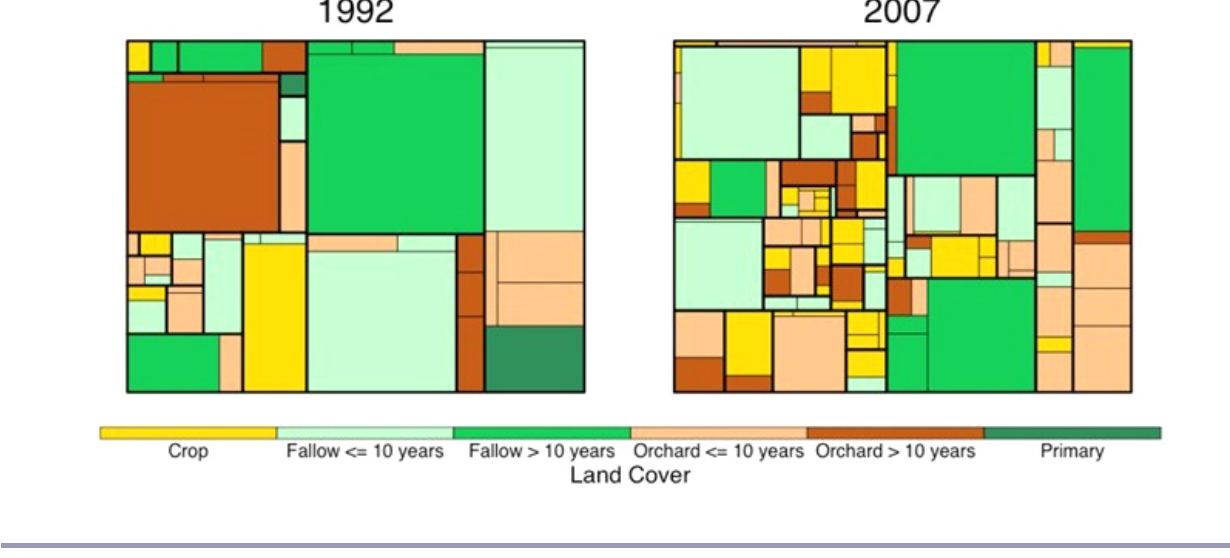
Fig. 5 . Tree maps of land cover by household holdings, San Jose, in 1992 and 2007. Bold lines enclose the fields (narrow lines) held by an individual household. Note that because the total land holdings increase through time, field sizes are only comparable within each tree map. Although field sizes are not directly comparable between dates, field sizes do decline through